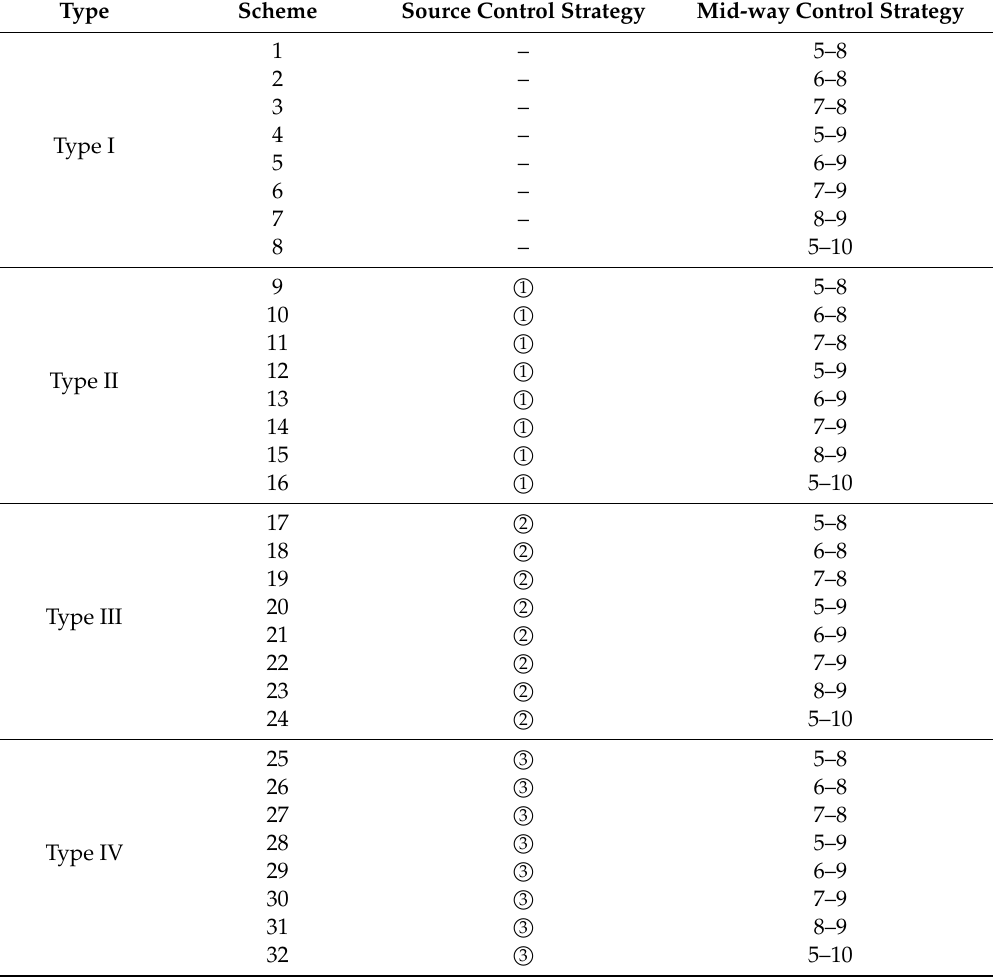
Table 4. Combined sewer overflow (CSO) control